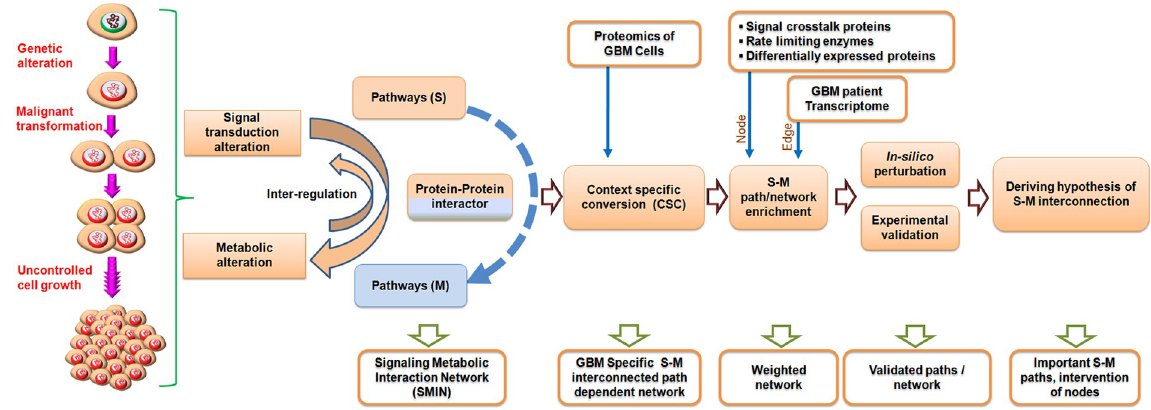
Fig 1. A schematic representation of the steps to establish the context-dependent signaling-metabolic interconnection model.